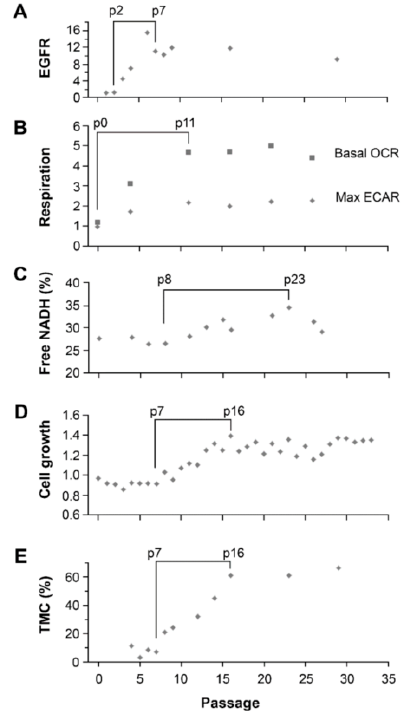
Figure 6. Sequential alterations of EGFR, metabolism, growth speed and subpopulation equilibrium in U251-NS over passages in SA-conditions. ( A ) Plot of EGFR levels in cells measured by immunoblotting, normalized to Actin and compared to that in p2. ( B ) Plot of average levels of basal OCR and maximum ECAR (combination of basal and spare) measured by flux analysis, compared to that in p0. ( C ) Plot of average free NADH fraction measured by FLIM. ( D ) Plot of overall cell growth speed (cell doubling per day) measured by counting the total number of cells at each passage, after a three-day culture from 5 × 10 5 cells in a 100-mm dish with 10 mL culture medium (DMEM/F12 + 5% FBS). ( E ) Plot of the average proportion cells with three copies of Chr7 within the cell subpopulation as measured by FISH. Data presented in ( A ) and ( B ) were shown in Figures 4 and 5 above; ( C ) and ( D ) from Hu et al. 2013 [15]; and ( E ) shows the combination of data shown in Figure 3 and from a repeat of FLIM on cells at low seeding density (2000 cells/well of an eight-well chamber slide). The periods with observed changes are braced.